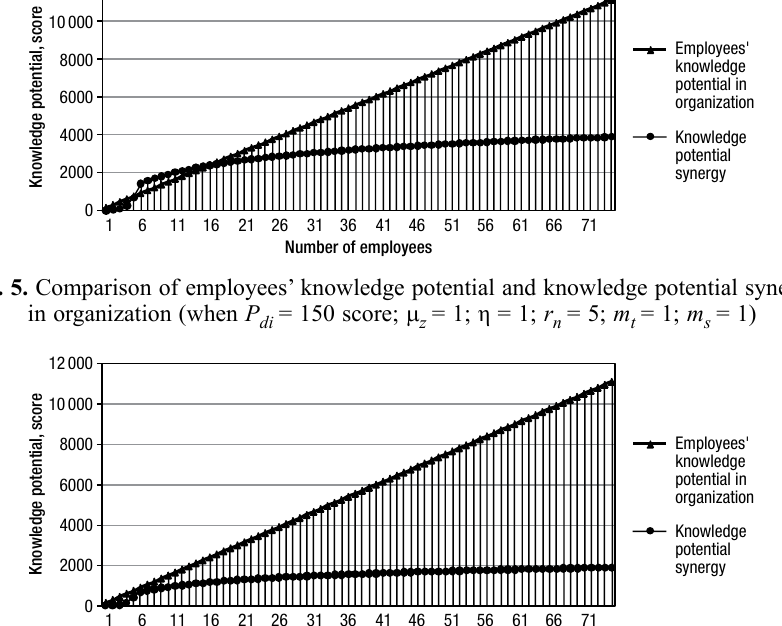
Fig. 6. Comparison of employees’ knowledge potential and knowledge potential synergy in organization (when P